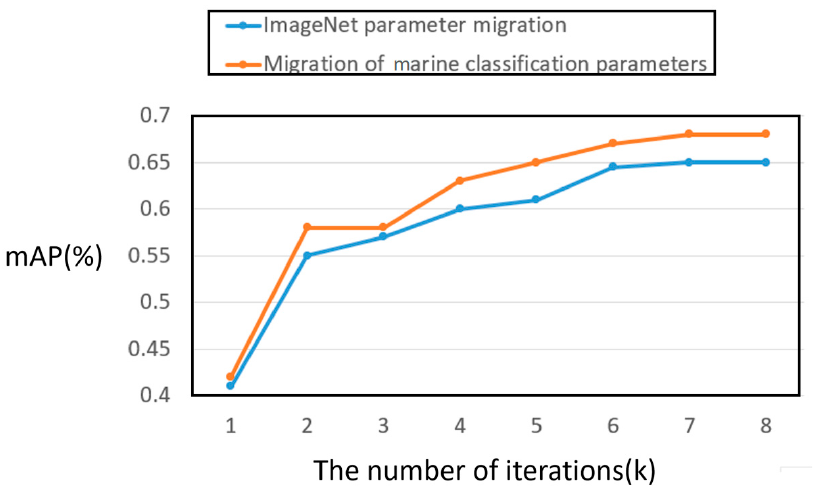
Figure 9. Comparison of MAP curves for target detection, with or without parameter migration, in a small-sample